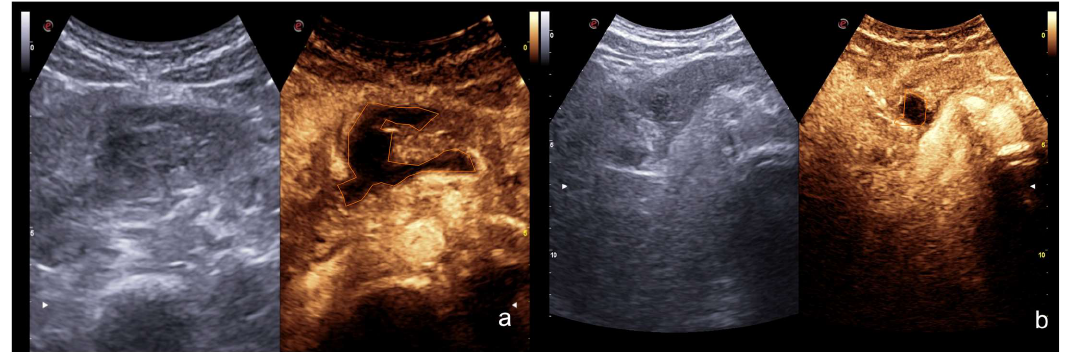
Figure 16. CEUS at day 1 ( a ) and after 2 weeks ( b ) in pancreatic trauma; note the reduction of the contusion area of pancreatic head, as well as of the peri-pancreatic fluid collection (orange line).